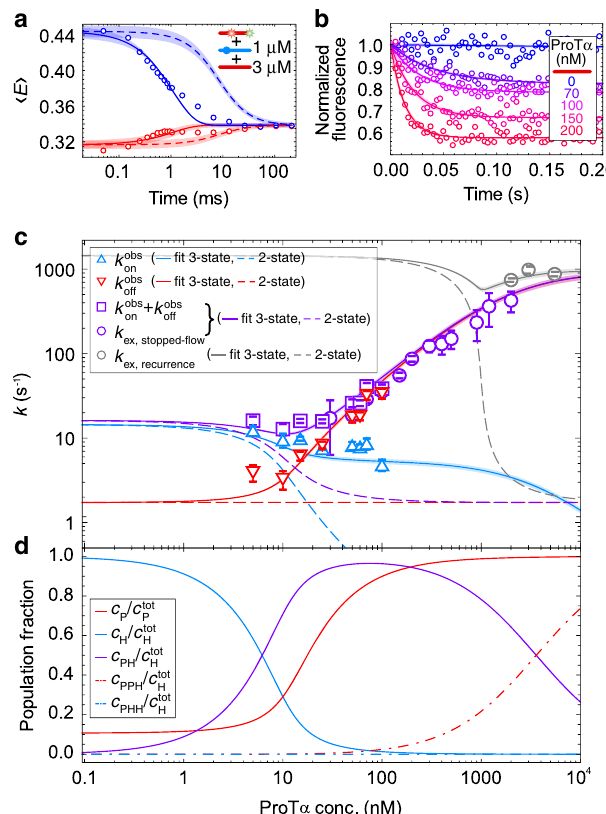
Fig. 4 Ternary complex formation explains kinetics over a broad range of concentrations. a Kinetic recurrence analysis 24 of 50 pM ProT α E56C/ D110C Alexa Fluor 488/594 with 1 µ M unlabeled H1 and 3 µ M unlabeled ProT α , showing the bound (blue) and unbound (red) states at different delay times with global fi t (solid lines) using a single relaxation rate, resulting in k ex = (864 ± 77) s − 1 . Dashed lines show the contribution to the relaxation due to the occurrence of new molecules in the confocal